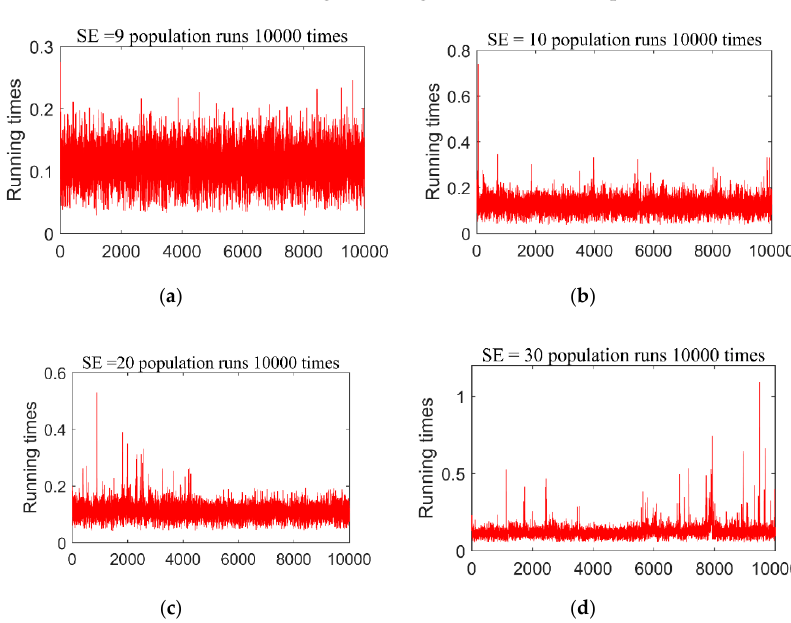
Figure 5. Different species run 10,000 times (( a ). SE=9 population runs 10000 times. ( b ) . SE=10 Figure population runs 10000 times. ( c ). SE=20 population runs 10000 times. ( d ) . SE=30 population runs 10000 times ).